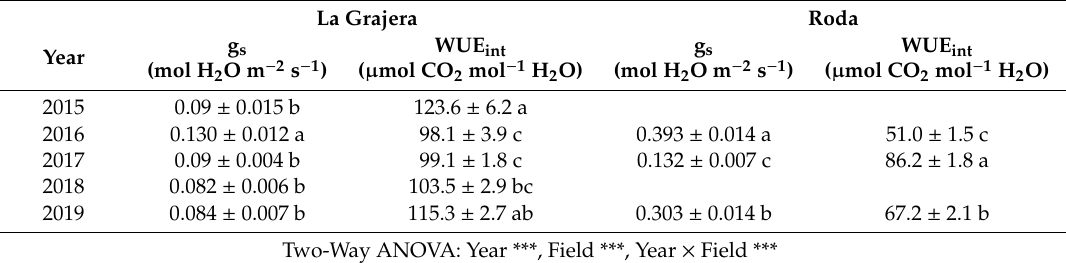
Table 2. Monthly averages of g s and water use e ffi ciency (WUE i ) in the two experimental fields. La